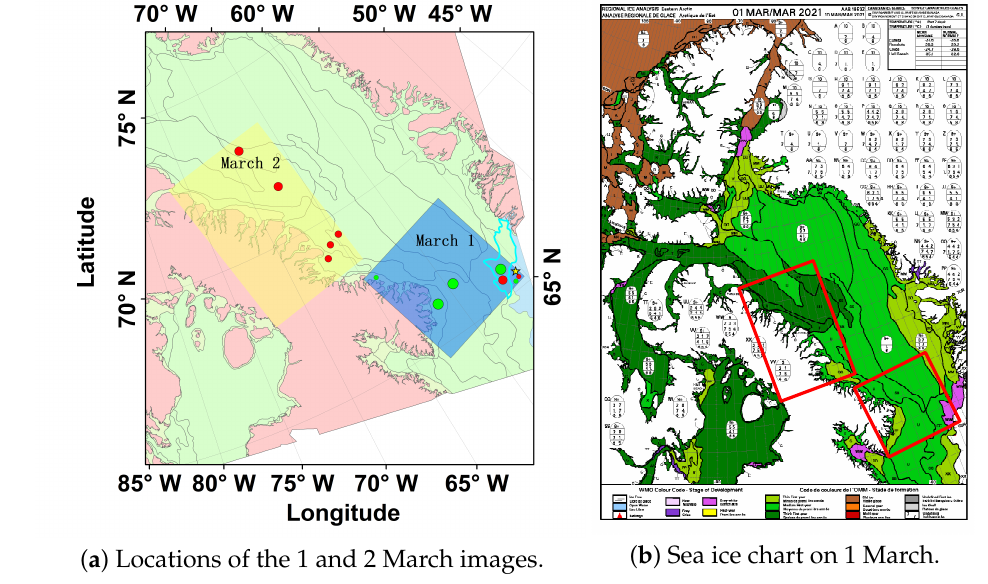
( a ) Locations of the 1 and 2 March images. ( b ) Sea ice chart on 1 March.